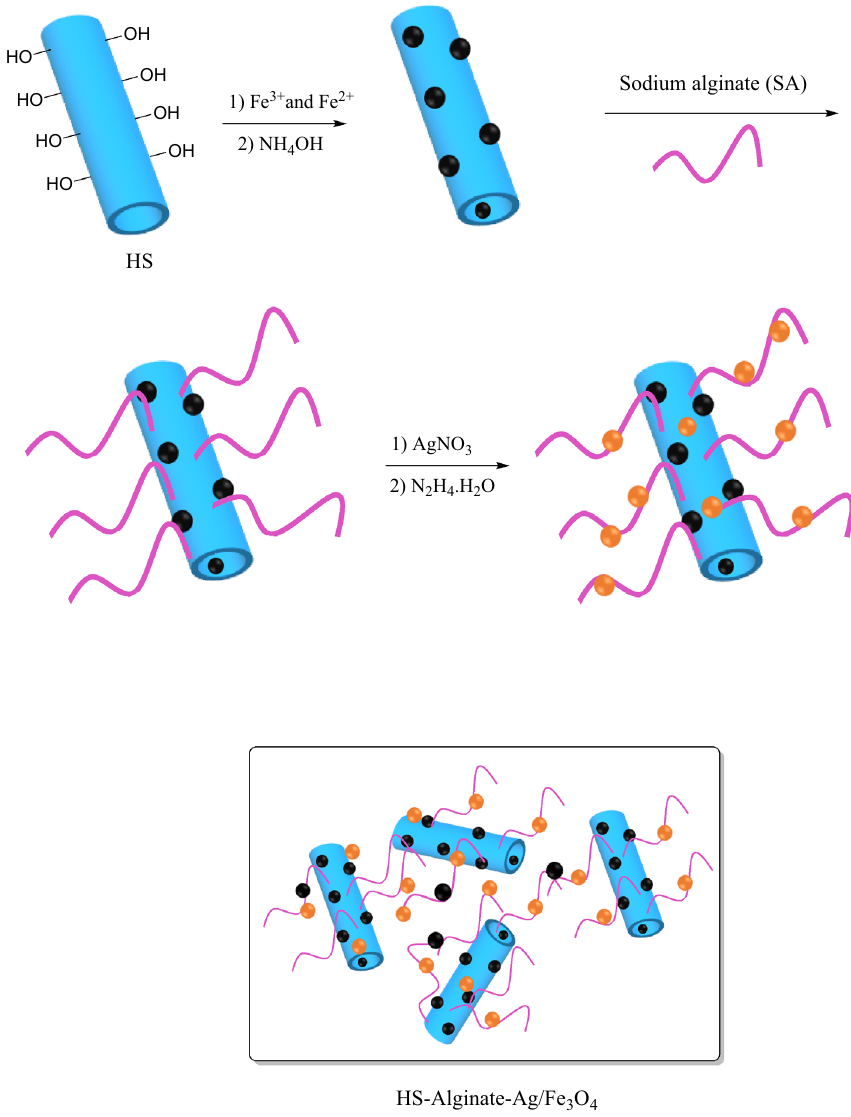
Figure 1. The nanocatalyst synthesis pathway (drawn with ChemDraw Pro 12.0 software (https:// en. freed ownlo adman ager. org/ Windo ws- PC/ ChemD raw- Pro.